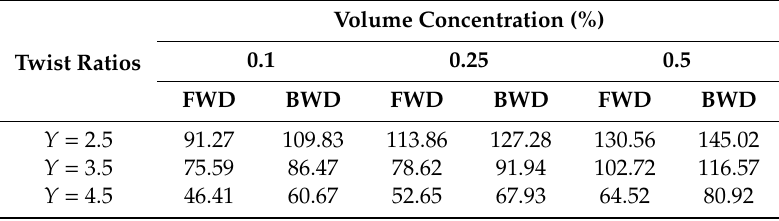
Table 4. Heat transfer augmentation (in %) of conical strip inserts at di ff erent twist ratios and volume concentrations of ZrO 2 / DI water